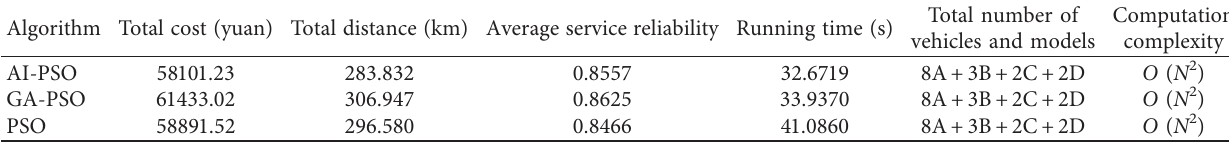
Table 11: Three methods are used to calculate the results under a dynamic